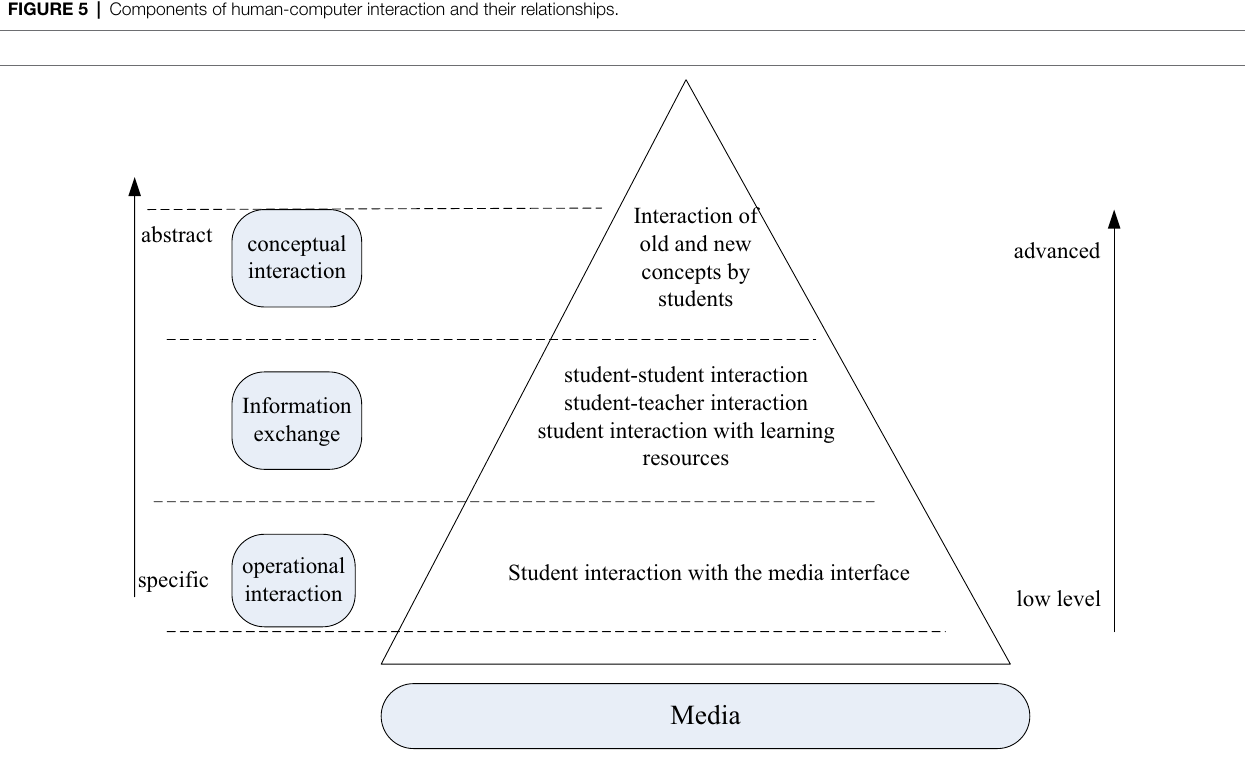
FIGURE 6 | Teaching Interaction Hierarchy